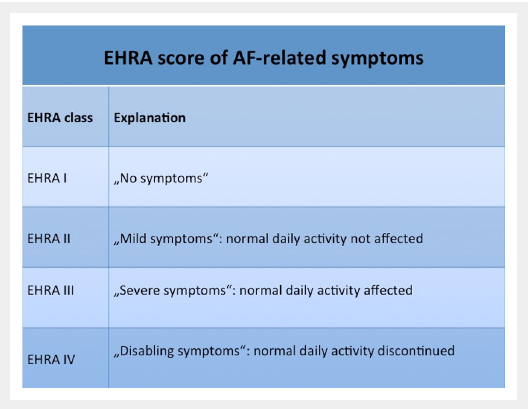
Figure 2 European Heart Rhythm Association (EHRA) classification of symptoms related to atrial fibrillation.